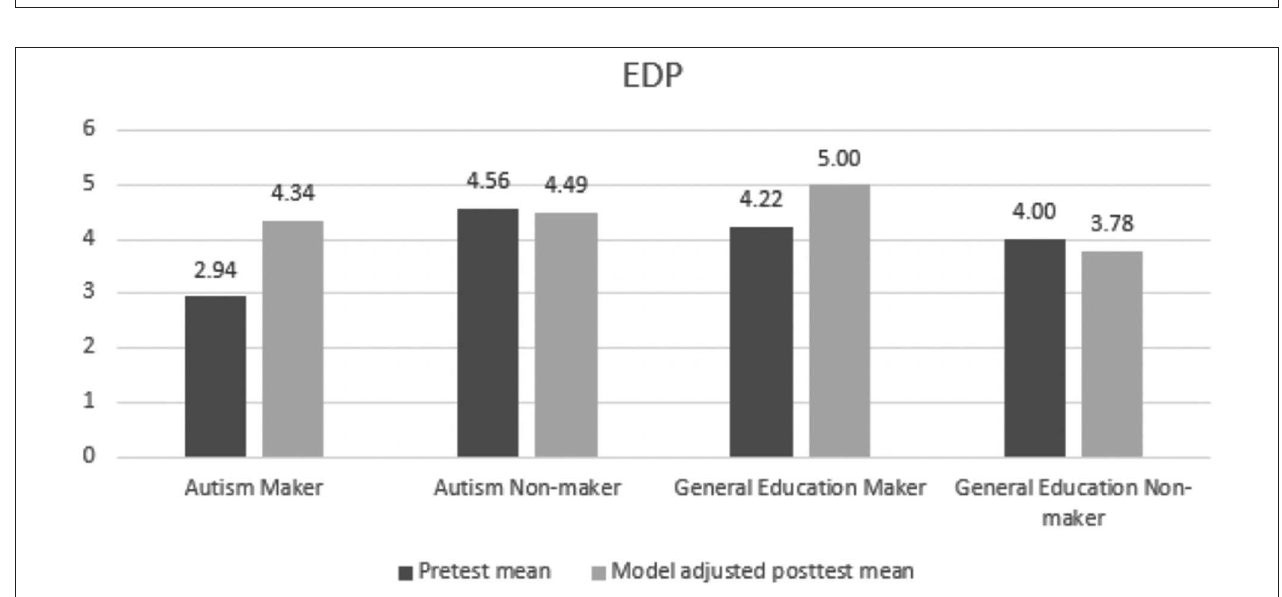
FIGURE 7 | Estimated means for the Engineering Design Process.